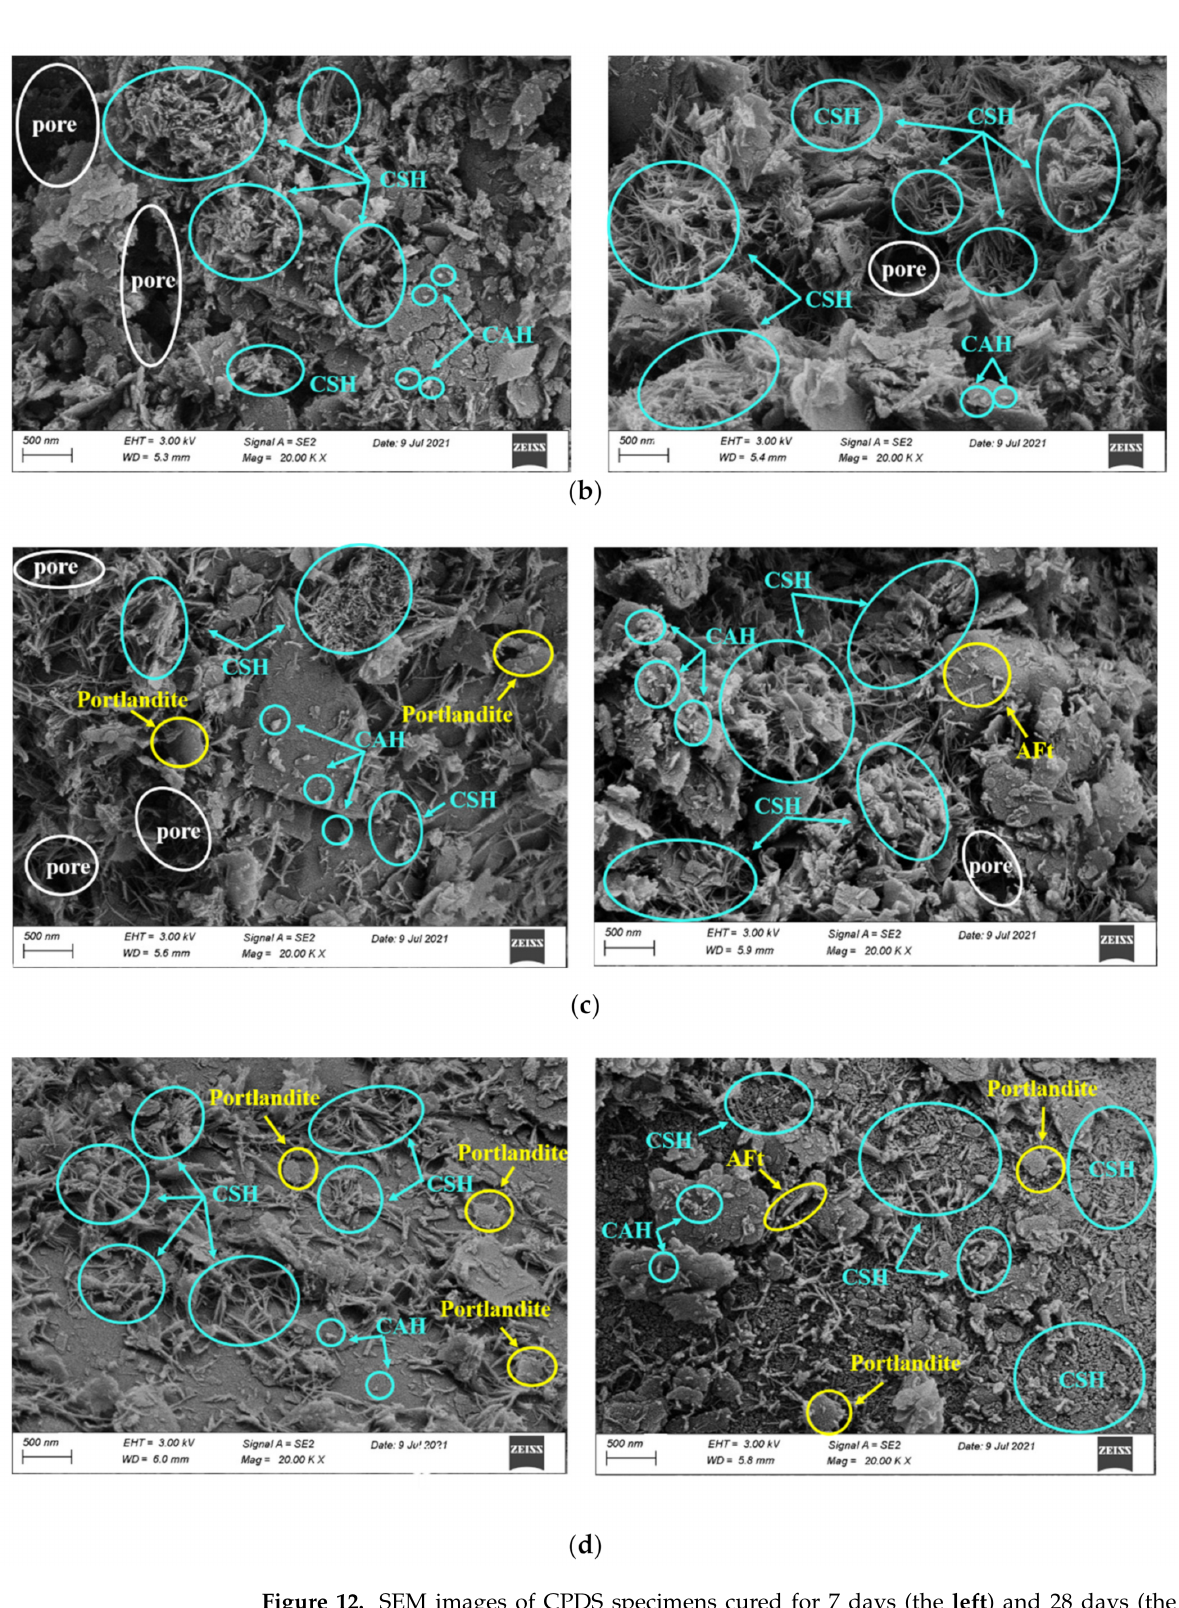
Figure 12. SEM images of CPDS specimens cured for 7 days (the left ) and 28 days (the right ). ( a ) Specimens P20C0; ( b ) Specimens P20C10; ( c ) Specimens P20C20; ( d ) Specimens